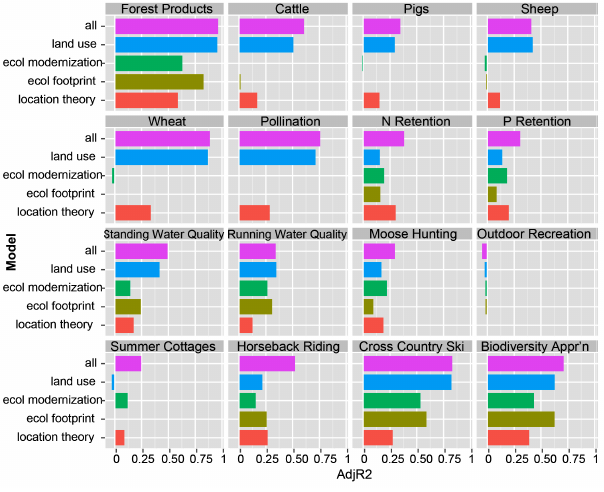
Fig. 4 . Best models for predicting individual ecosystem services. Each bar graph represents each model’s R² value for predicting each ecosystem